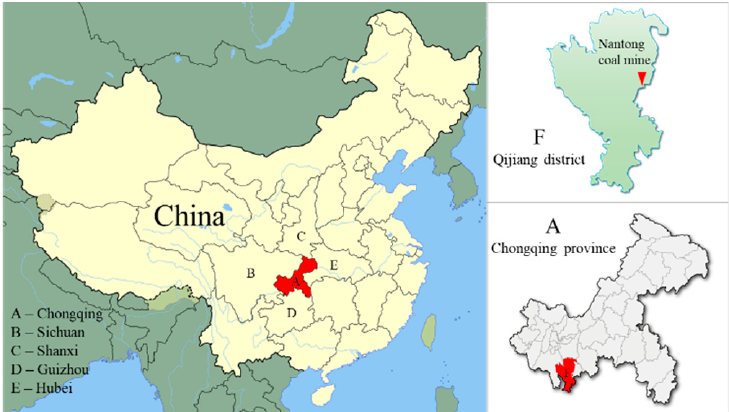
Figure 1. Location of Nantong coalmine.